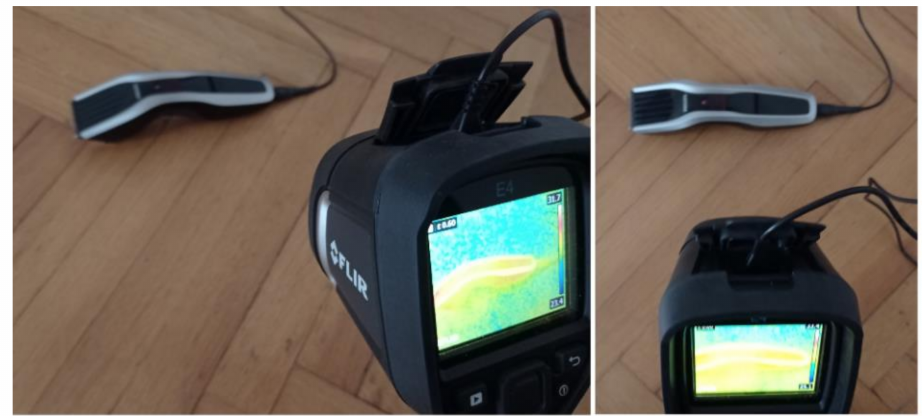
Figure 12. Thermographic measurements for the BLDC motor (clipper HC5440/80).